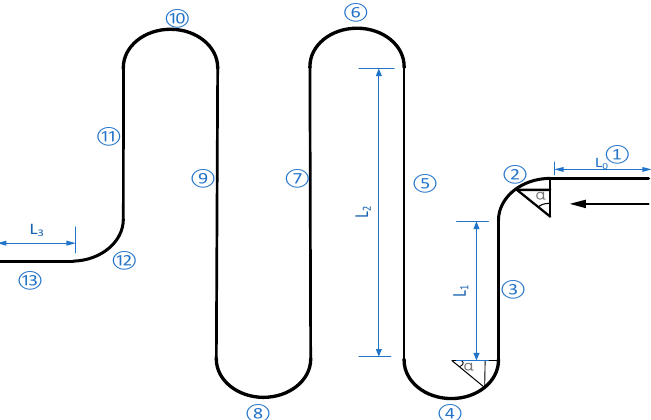
Figure 4. Sensitive structure of the S-shaped elastic beam’s equivalent simplified form.